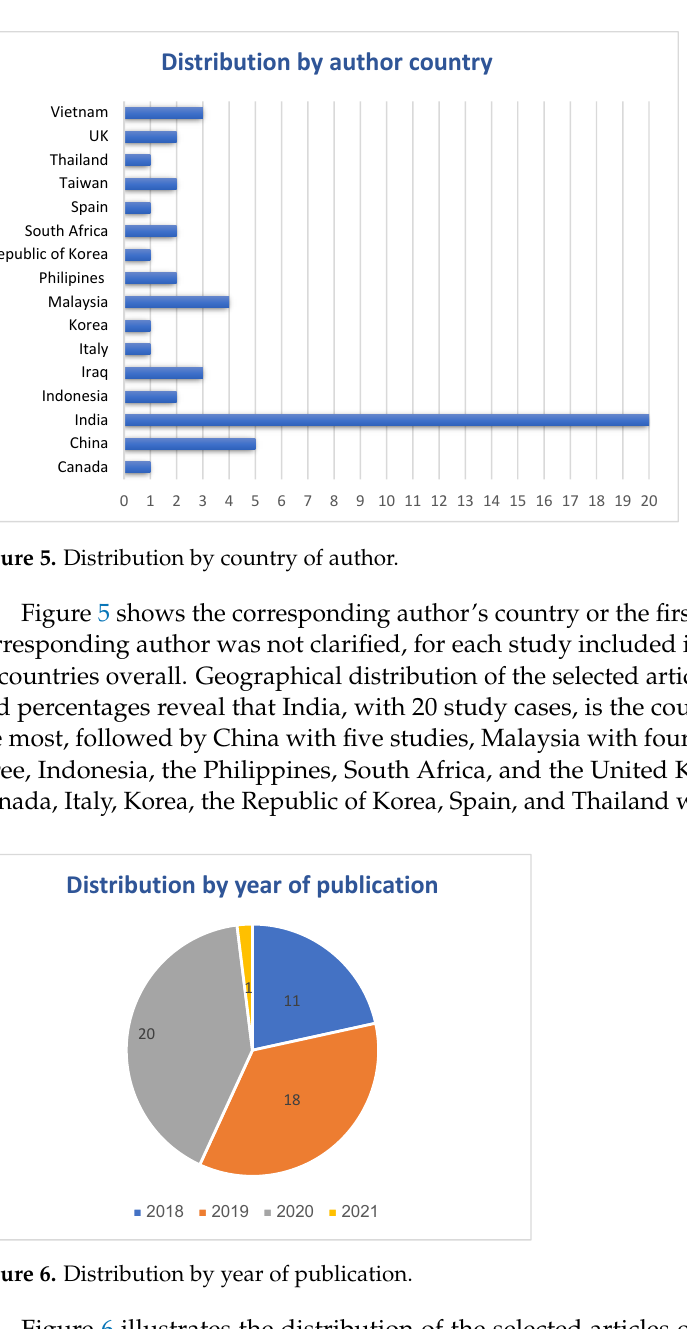
Figure 6. Distribution by year of publication.